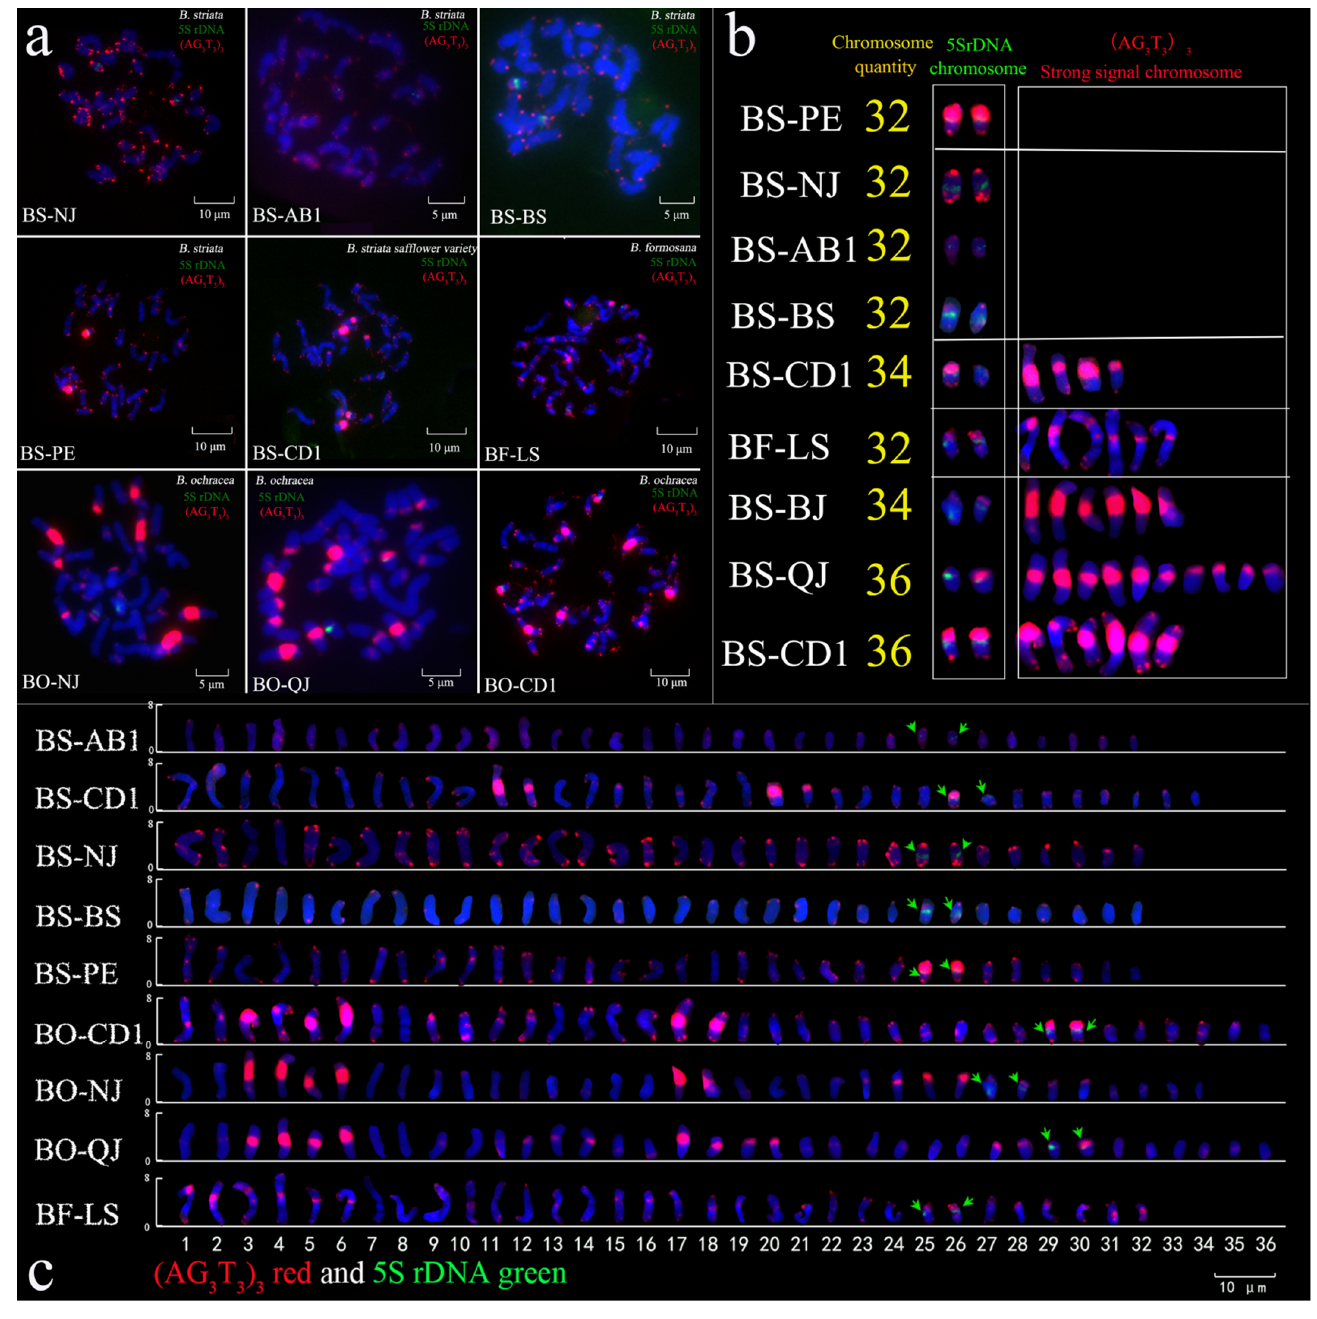
Figure 3. ( a ) Fluorescence in situ hybridization of Bletilla ; ( b ) signal-mode difference diagram; ( c ) chromosomes vector graphs. Red represents 5S rDNA, while green represents (AG 3 T 3 ) 3 . The blue chromosomes were counterstained with DAPI. Scale bar = 5 μ m or 10 μ m. BS-AB1: B. striata from Aba, Sichuan No 1; BS-CD1: B. striata from Dujiangyan, Sichuan No 1; BS-NJ: B. striata from Neijiang, Sichuan; BS-PE: B. striata from Pu’er, Yunnan; BS-BS: B. striata from Baoshan, Yunnan; BO-CD1: B. ochracea from Jingtang, Sichuan No1; BO-QJ: B. ochracea from Qujing, Yunnan; BO-NJ: B. ochracea from Neijiang, Sichuan; BF-LS: B. formosana from Leshan, Sichuan.